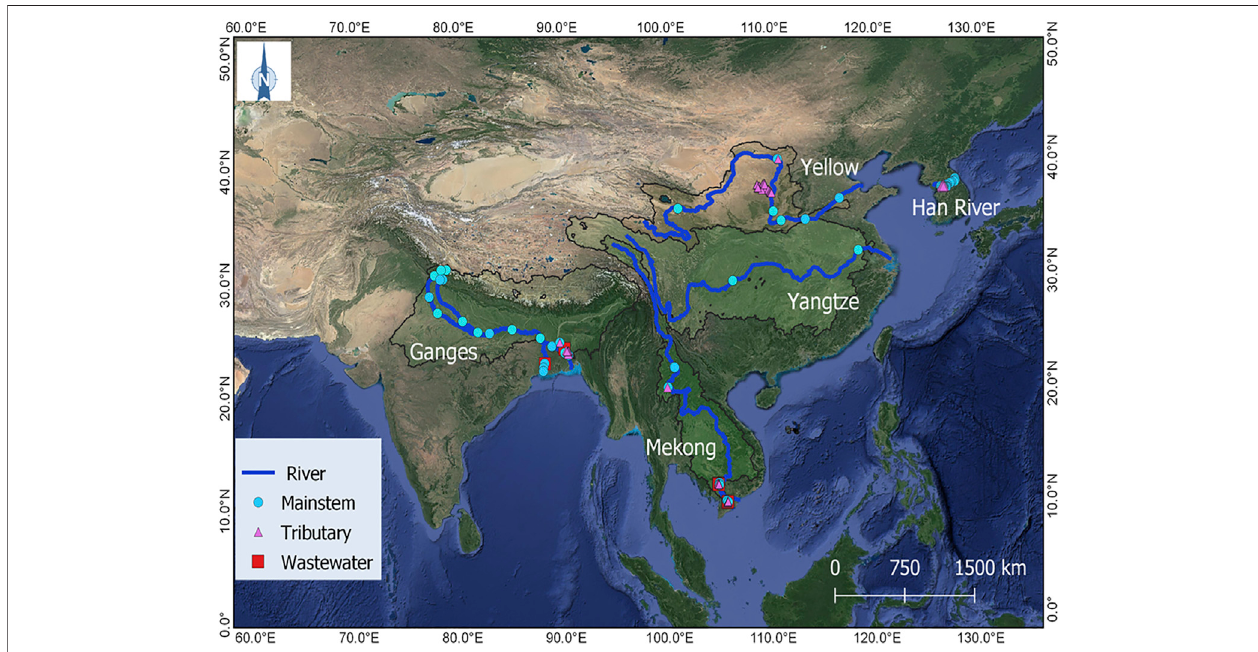
FIGURE1| Study mapshowingthe sampling sites acrossthemainstems, tributaries, and pollutedurban tributaries orwastewater ef fl uents offour large rivers(the Ganges, Mekong, Yangtze, and Yellow River) and a smaller, urbanized river system in Korea (the Han River).